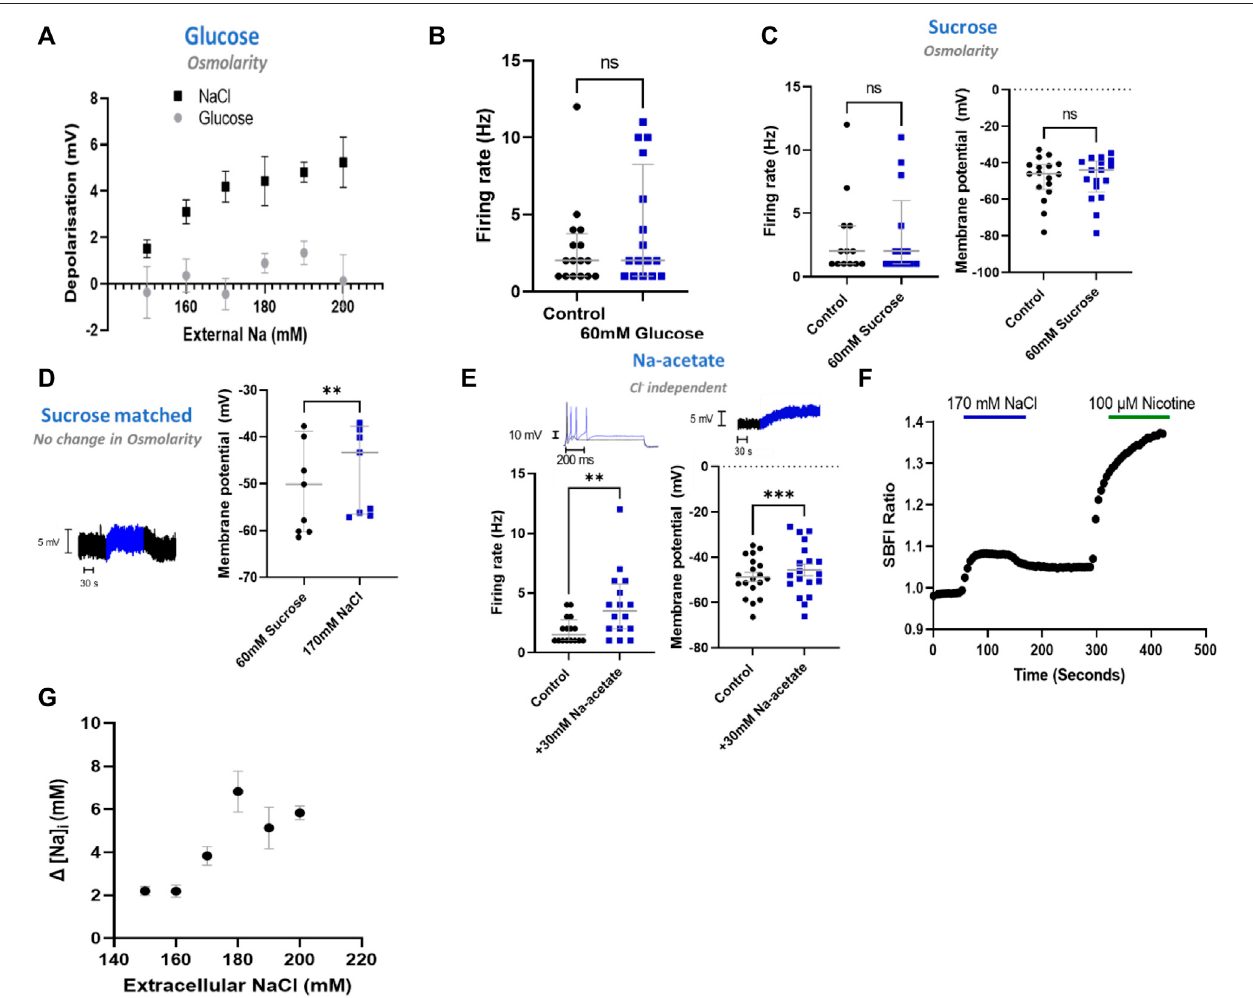
FIGURE 2 | NaCl evokes an effect in stellate ganglia neurons independent of osmolarity. (A) Osmolarity matched glucose controls did not induce membrane depolarization like NaCl. Over the range 20 mM – 120 mM glucose, osmolarity matched NaCl caused a signi fi cantly greater depolarization than tested concentrations of glucose (Two-way ANOVA; p < 0.0001) (NaCl, n = 15 – 22; Glucose, n = 8 – 15). (B) The addition of 60 mM glucose had no statistically detectable effect upon neuronal fi ring. 60 mM glucose did not signi fi cantly alter stellate ganglia neuron fi ring (n = 16; Wilcoxon test; p = 0.09). (C) 60 mM sucrose had no effect upon induced neuronal fi ringormembranepotential.Firingratewasunalteredfollowingtheadditionof60 mMsucrose(n=13;Wilcoxontest; p =0.50),aswastheneuronalmembrane potential (n = 17; Paired t -test; p = 0.95). (D) 170 mM NaCl induced a response from osmolarity matched solution high sucrose solution. Transitioning from 60 mM sucrose control solutions to 170 mM NaCl in the presence of 1 µM TTX still elicited a membrane depolarization despite balanced osmolarity (n = 9; Paired t -test; p = 0.005). (E) The response was not Cl − dependent as 30 mM Na-acetate increased stellate ganglia neuron fi ring rate (1.5 Hz – 3.5 Hz; n = 14; Wilcoxon test; p = 0.02) and depolarized the membrane potential(3.08 ±0.71 mV; n =17; Paired t -test; p = 0.002). Firing rate isshown before (black) and after (blue) 30 mM Na-Acetate (Left trace). Membrane depolarization is shown following 170 mM NaCl. (F) A raw SBFI data trace, showing the response to 170 mM NaCl (Blue) and 100 µM nicotine (Green) for comparison. (G) Elevated[NaCl] o causedadose-depednentincreaseinintracellularNa + concentration([Na + ] i )(KruskalWallistest, p < 0.0001),asmeasuredwiththeNa + selective dye SBFI. Dye ratios were converted to changes in NaCl, via the calibration curve in extended data Figure 1 .